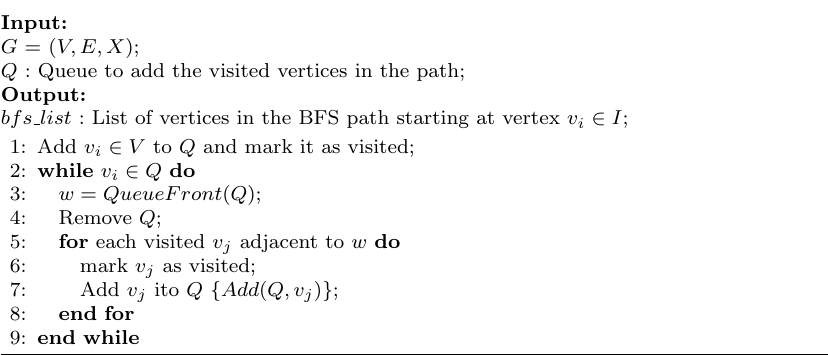
Algorithm 5 Bredth First Search Tree (BFS